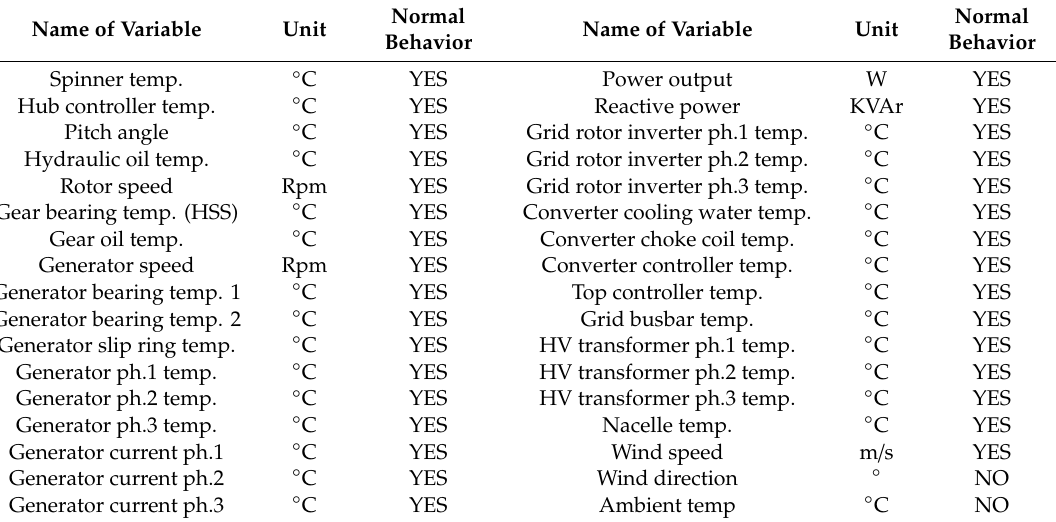
Table 1. SCADA data list for the development of normal behavior